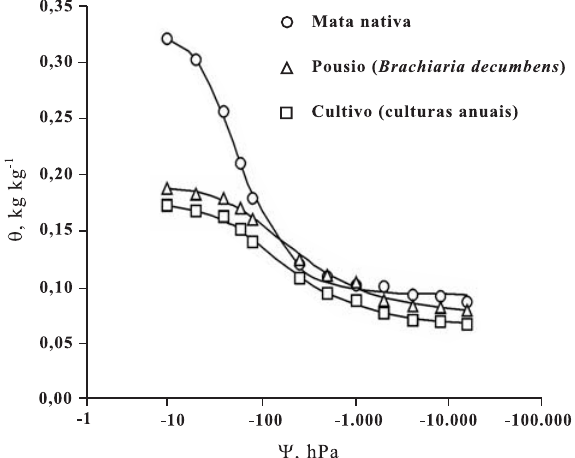
Figura 1. Curvas de retenção de água no solo para os sistemas de uso do solo sob cultivo (culturas anuais), pousio ( Brachiaria decumbens ) e